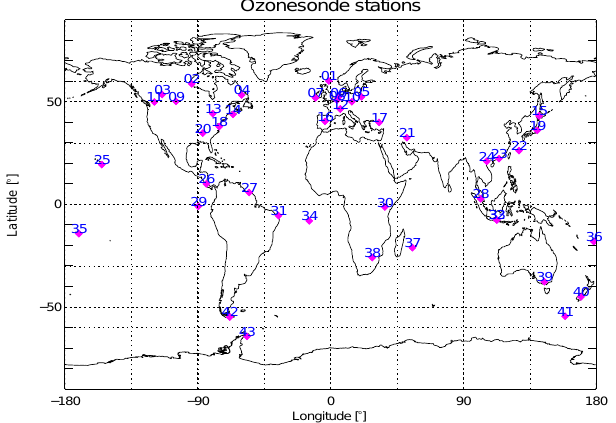
Figure 5. World map showing ozonesonde stations (station numbers are listed in Table 4) used in this study.